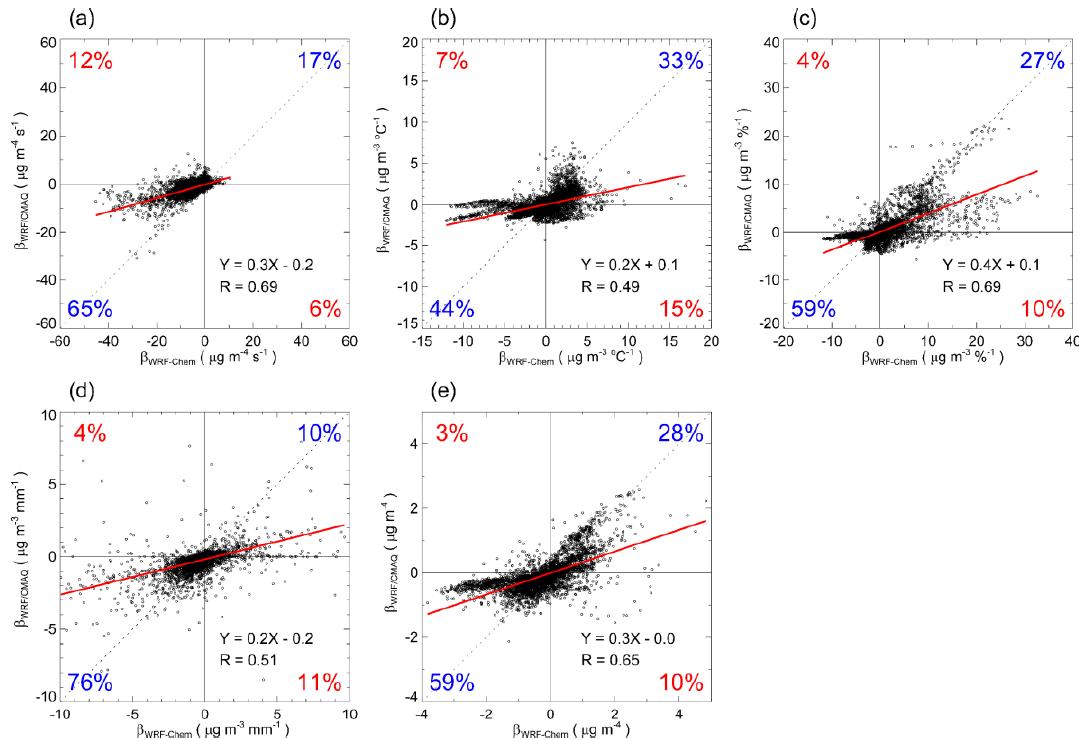
Figure 13. Comparison of the regression coefficients ( 𝛽 𝑖 ) estimated from the WRF-Chem and WRF/CMAQ models for ( a ) 10-m wind speed, ( b ) 2-m temperature, ( c ) relative humidity, ( d ) precipitation, and (e) PBL height.